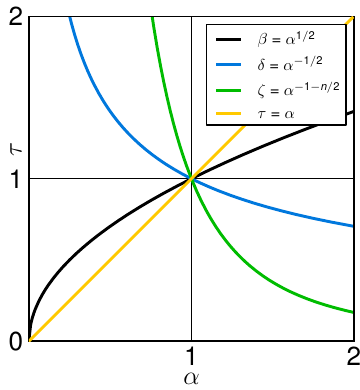
Figure 8. Scaling of response time τ , surface mass balance δ and ice softness ζ under the assumption of Vialov-type geometric scal- ing ( β = α 1 / 2 ) and identical basal friction ( γ = 1). The resulting scaling conditions are independent of m and given in the legend ( n =